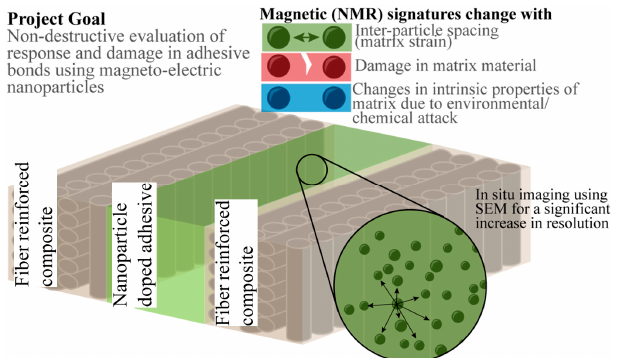
Figure 1. Possible sample loading history influences on the output magnetic signal of MEN-doped adhesives.